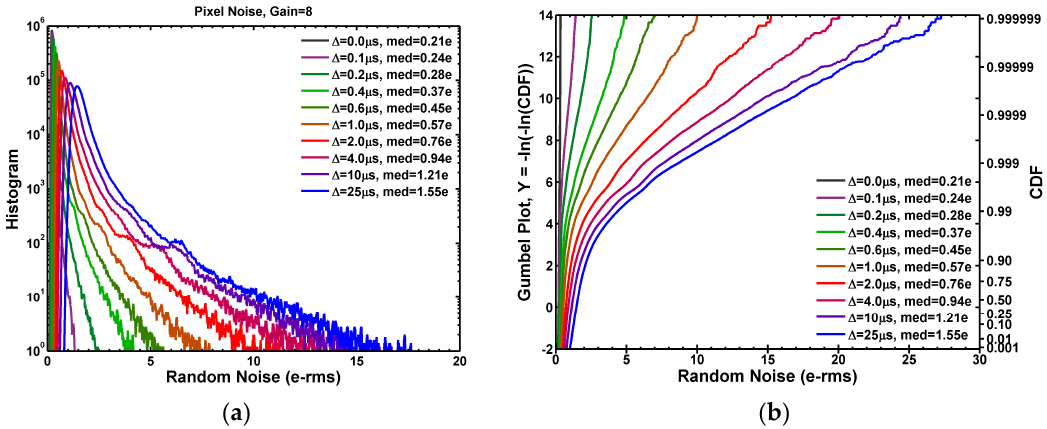
Figure 12. ( a ) The family of RN histograms when the double sampling time difference Δ t is gradually increased from 0 to 25 μ s; ( b ) The Gumbel plots of the family of the CDF (cumulative distribution function) curves, which are approximately linear in the high noise region with RN > 10 e − rms.